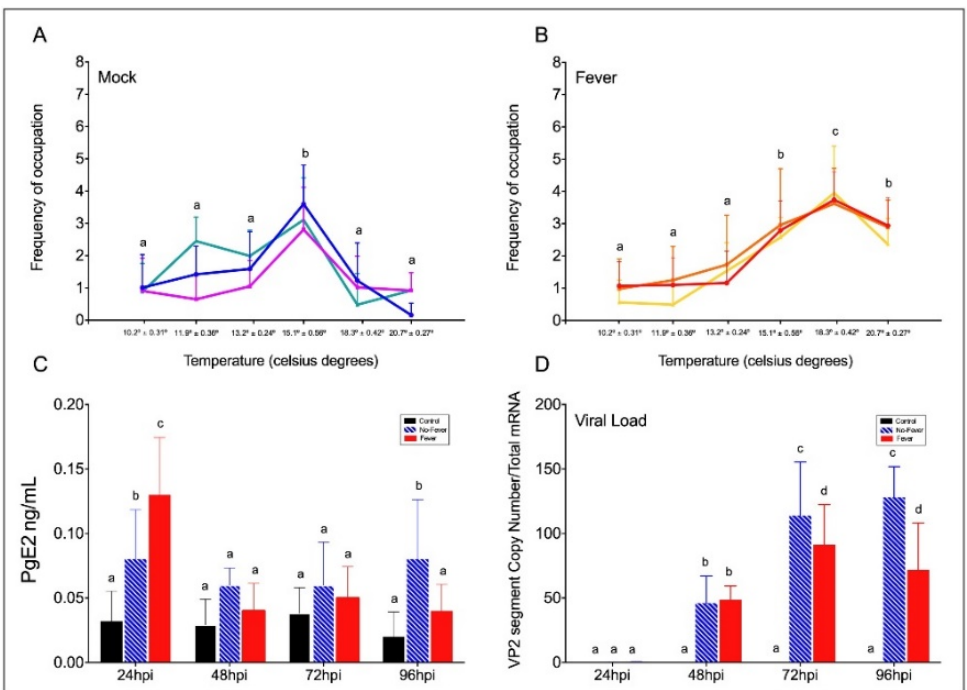
Figure 2. Behavioural fever in IPNV-challenged Salmon salar . ( A ) Frequency of chamber occupation in non-challenged individual fish (mock individuals = non-infected group in thermal gradient tank) over the 96 hpi period. The blue, green, and purple lines represent the frequency of occupation in each chamber by each technical replicate; mock ( n = 3 technical replicates, mean ± SD). ( B ) Frequency of chamber occupation of IPNV-challenged individual fish. The red, yellow, and orange lines represent the frequency of occupation in each chamber by each technical replicate of fish challenged with IPNV under thermal gradient tank ( n = 3 technical replicates, mean ± SD). ( C ) Plasma concentration of PgE2 (ng ml − 1 ) in IPNV-infected fish. Bar graph showing differences between control (uninfected fish, black bars), no-fever (dashed blue bars), and fever (red bars) individuals (mean ± SD, two-way ANOVA followed by Tukey’s post hoc test, p < 0.0001). Different letters denote significant differences. ( D ) Viral load expressed as the abundance of VP2 segment (targeted with primer WB117) of the IPNV detected by RT-qPCR in the spleen. Bar graphs showing the differences between control (uninfected fish, black bars), no-fever (dashed blue bars), and fever (red bars) individuals (mean ± SD, two-way ANOVA followed by Tukey’s post hoc test, p < 0.001). Different letters denote significant differences. The mean and SD value for the copy number of the VP2 segment transcript per ng of total RNA is shown. IPNV: infectious pancreatic necrosis virus; hpi: hours post-infection; SD: standard deviation.